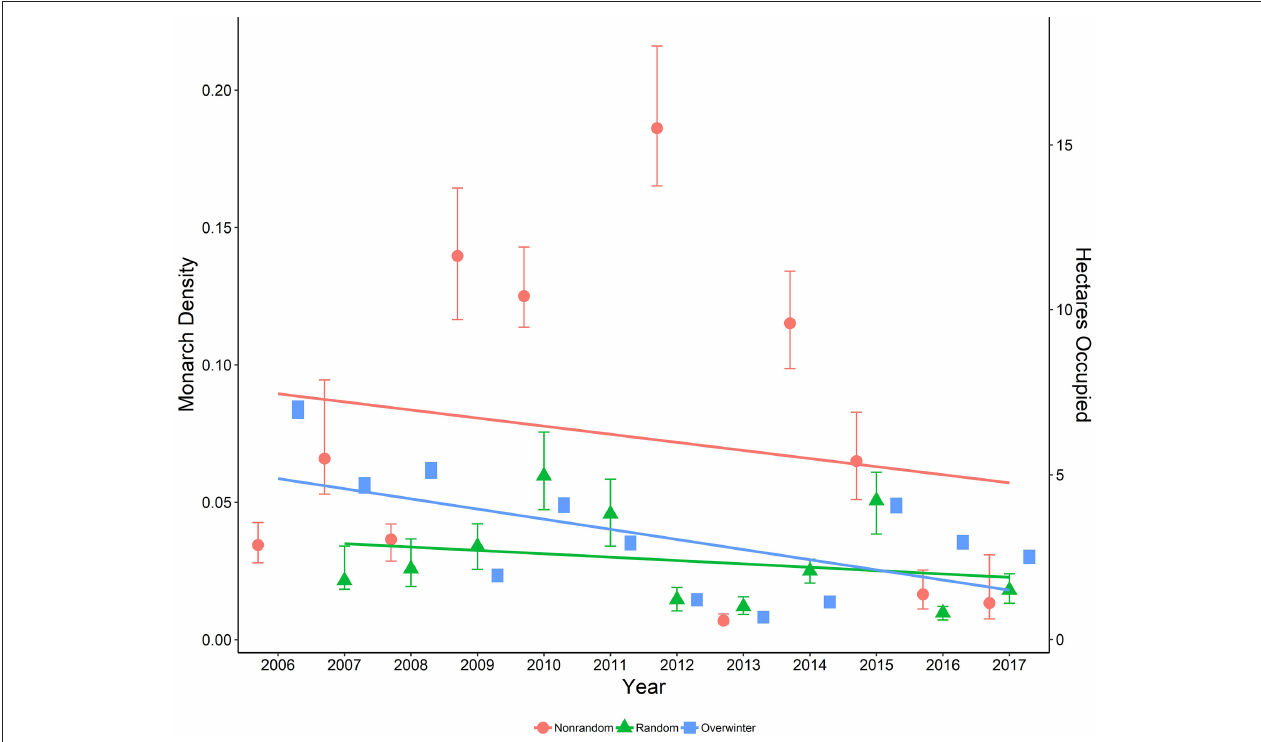
FIGURE 5 | Estimated density per 50-m 2 (95% CI) of monarchs on both random and non-random sites surveyed in Iowa by year, 2006-2017, along with data on area occupied (ha; secondary axis) by overwintering monarchs in Mexico, 2006-2017 ( Monarch Watch Blog,